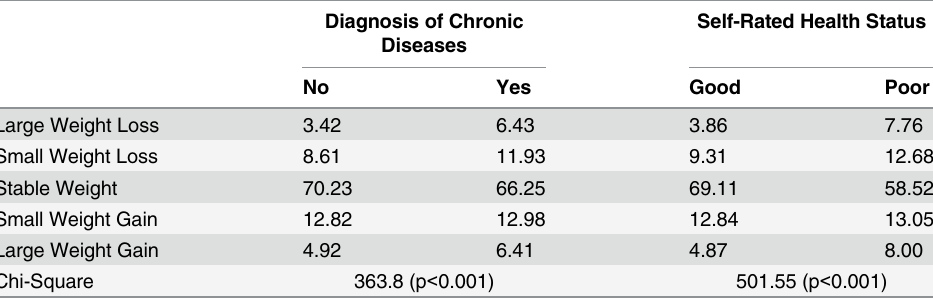
Table 2. Distribution of Weight Change by Previous Health